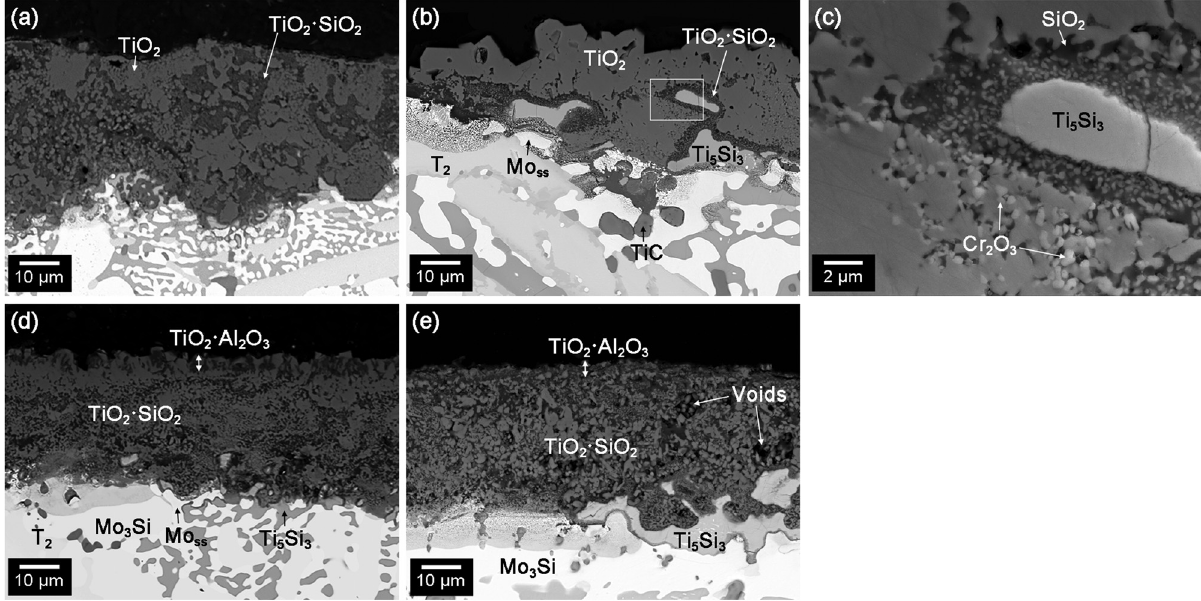
Figure 9: Cross - section microstructures of the ( a ) base, ( b ) 10Cr, ( d ) 5Cr5Al and ( e ) 10Al alloys oxidized at 1,100°C for 12 h, ( c ) high magnification image of the squared area in ( b ) .